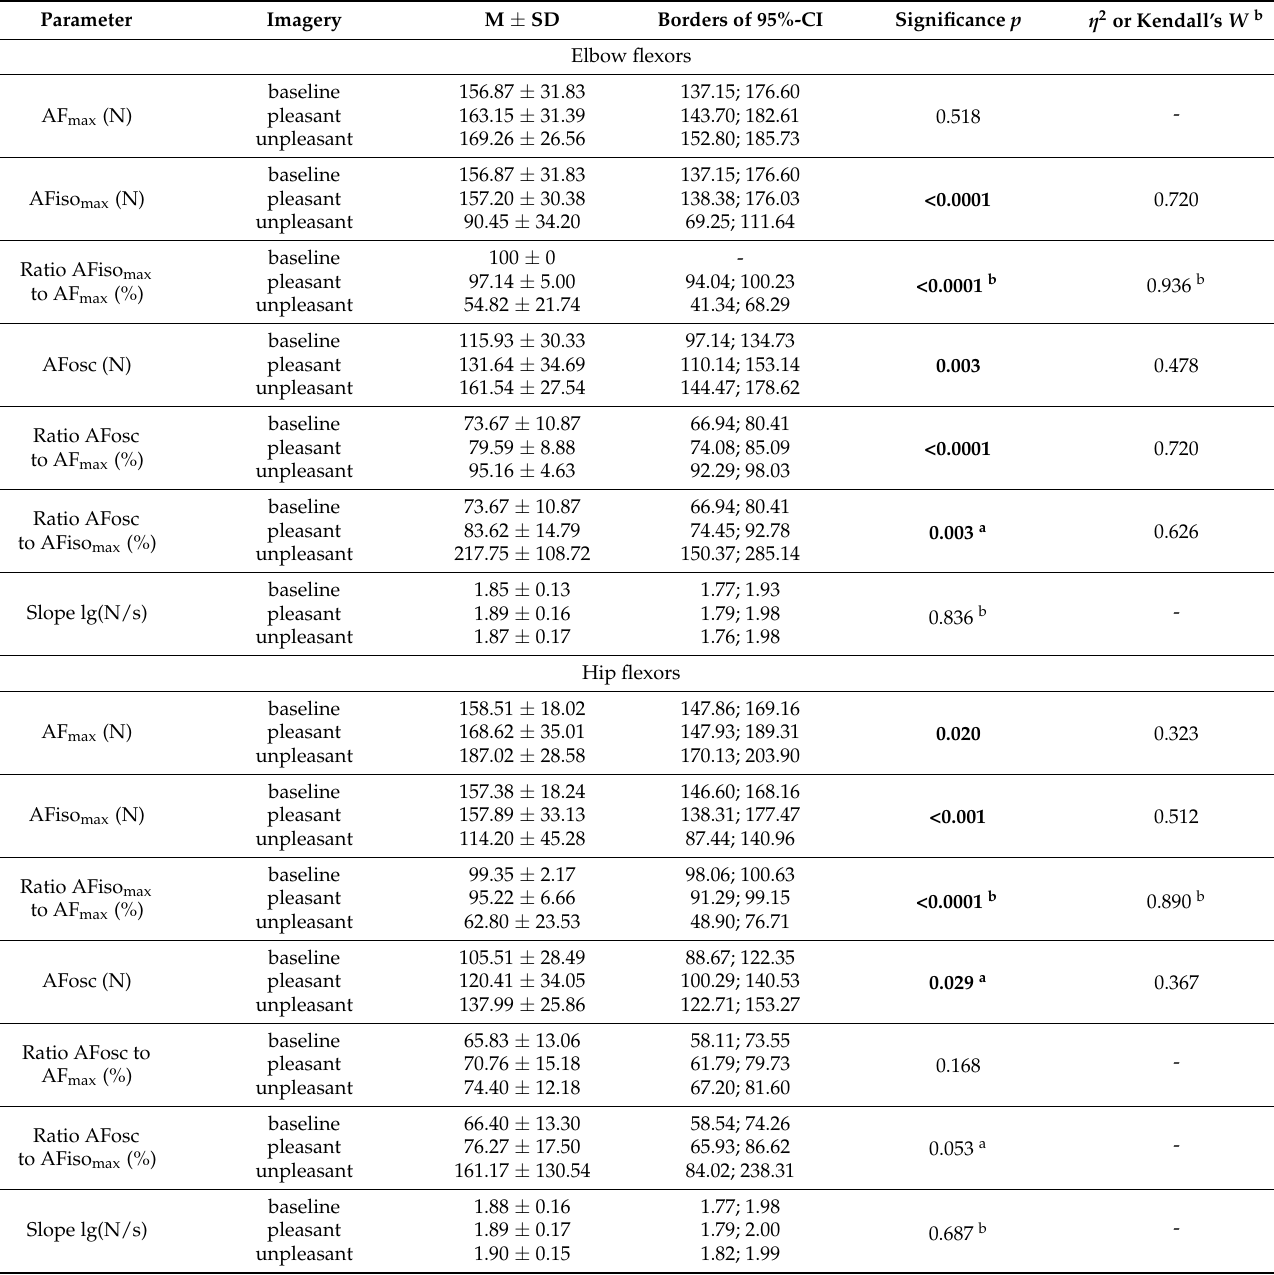
Table 1. Descriptive and statistical results of AF parameters. Arithmetic means (M), standard deviations (SD), lower and upper border of 95% CIs as well as p values and effect sizes η 2 or Kendall’s W of the AF parameters for baseline, pleasant and unpleasant imagery of elbow and hip flexors are